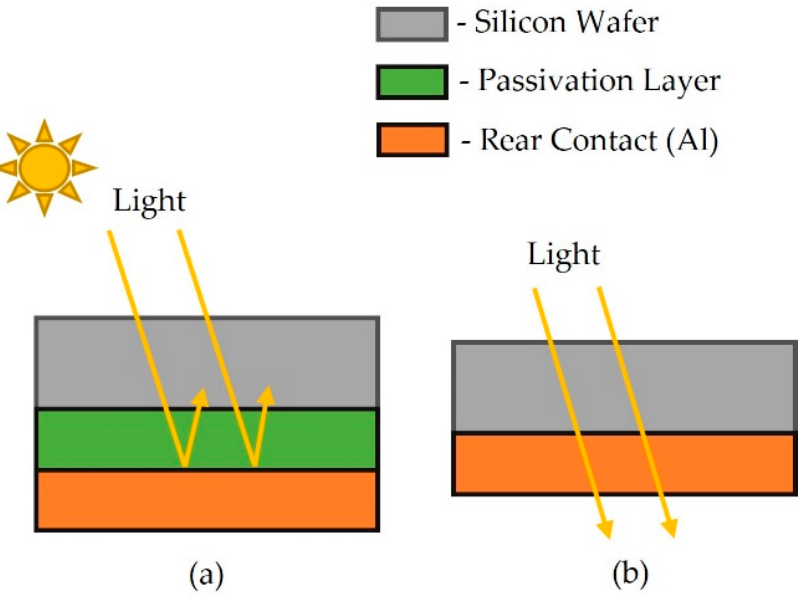
Figure 1. Difference between ( a ) PERC and ( b ) Al-BSF solar design. The first PERC solar cell was published in the year 1989, at an efficiency of 22.8% by [19]. The schematic of this PERC cells is presented in Figure 2. The structural design of PERC solar cell consists